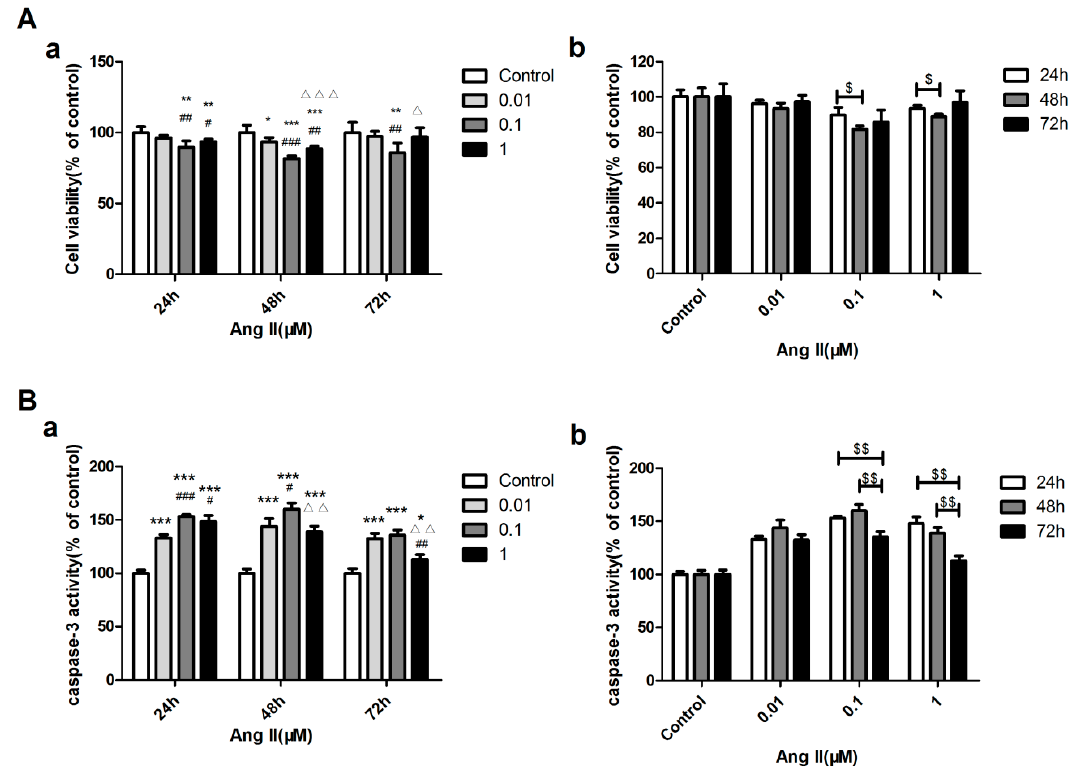
Figure 7. Concentration and acting time of Ang II-stimulated H9c2 cell apoptosis. ( A ) Cell viability was assessed using the MTT assay. H9c2 cells were seeded at a density of 5 × 10 3 cells per well into 96-well plates. ( a ) Effect of Ang II on the viability of H9c2 cells cultured with different concentrations (0.01, 0.1, 1 μ M·mol/L) for the same time; ( b ) Effect of Ang II on the viability of H9c2 cells cultured with the same concentration for different times (24, 48 or 72 h); ( B ) Caspase-3 activity assay was used to test the relative caspase-3 activity of the control. ( a ) Effect of Ang II on the caspase-3 activity of H9c2 cells cultured with different concentrations (0.01, 0.1, 1 μ M·mol/L) for the same time; ( b ) Effect of Ang II on the caspase-3 activity of H9c2 cells cultured with the same concentration for different times (24, 48 or 72 h). The data are presented as the mean ± standard deviation. * p < 0.05, ** p < 0.01, *** p < 0.001 versus the control group; # p < 0.05, ## p < 0.01, ### p < 0.001 versus the 0.01 μ M Ang II group; Δ p < 0.05, ΔΔ p < 0.01, ΔΔΔ p < 0.001 versus the 0.1 μ M Ang II group, $ p < 0.05, $$ p < 0.01.